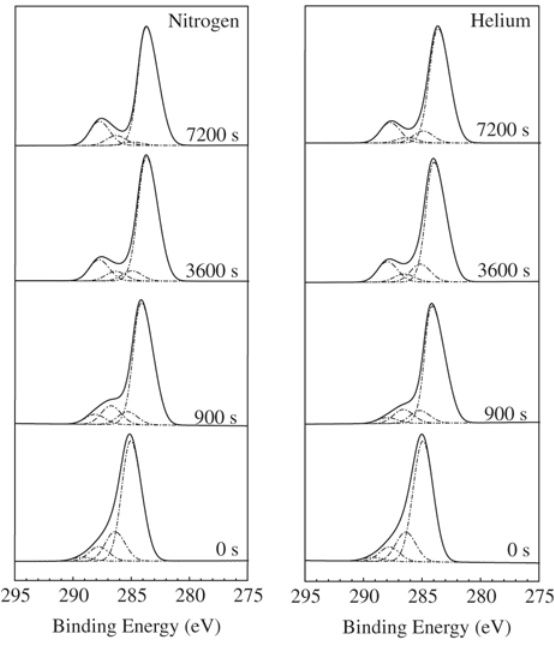
Figure 1. C 1s XPS spectra of PPA films bombarded with helium or nitrogen ions for different